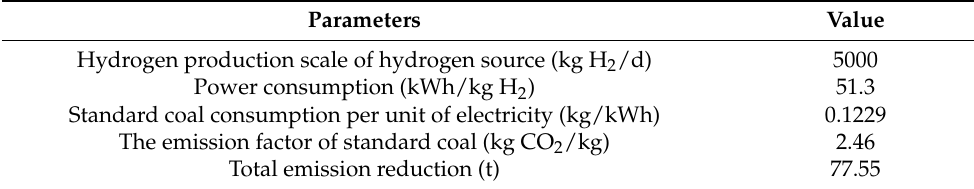
Table 12. Summary of emission reduction about single hydrogen source.